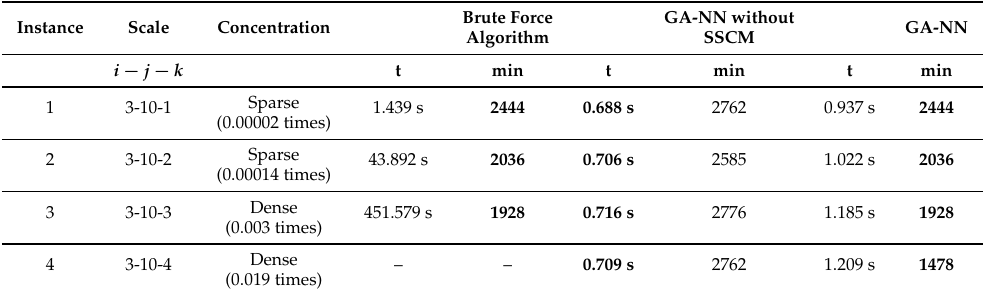
Table 3. Verification experiment of solution space compression